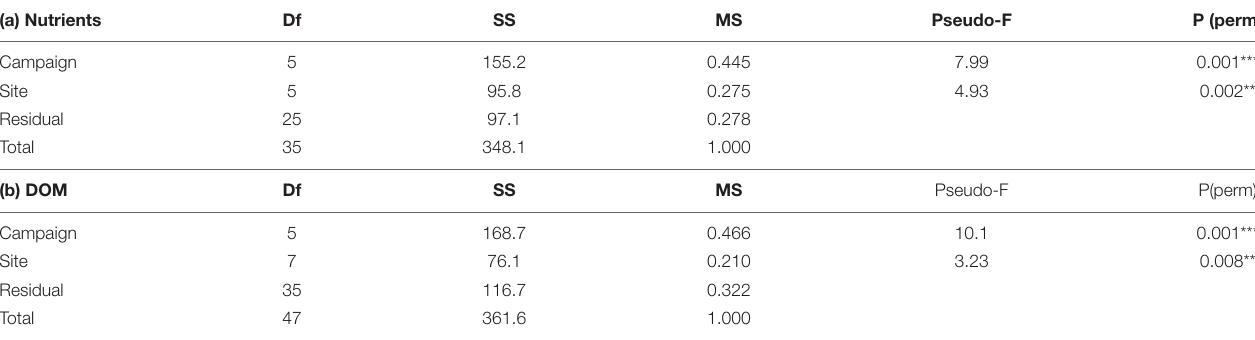
TABLE 2 | PERMANOVA analysis of (a) nutrients (N-total, P-total, NO 3 , NO 2 , and PO 4 ) and (b) DOM quality descriptors (PARAFAC components, CDOM, ColorPt, and DOC concentration), with sites and campaigns as factors. (a) Nutrients Df